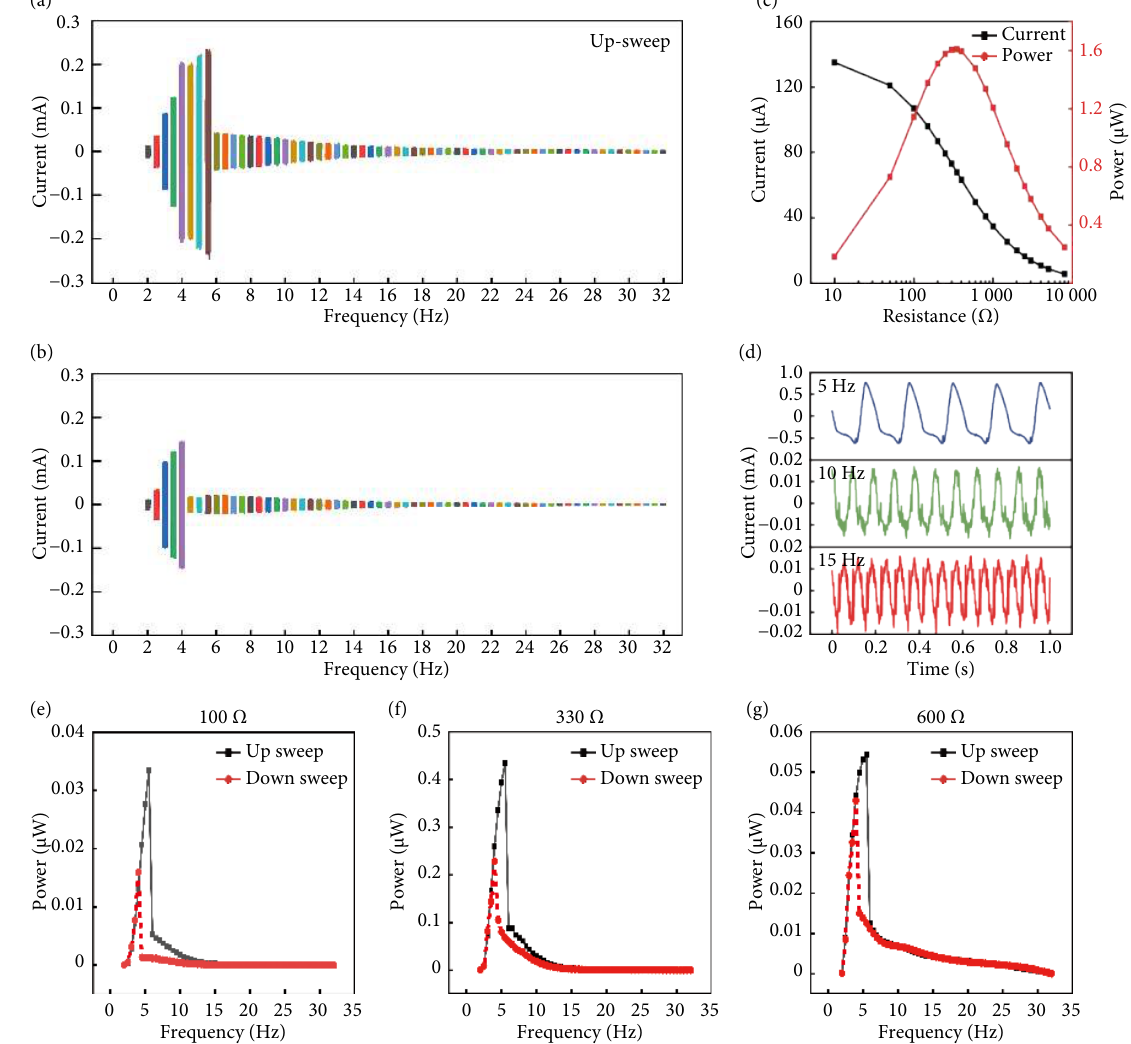
Fig. 3 Electric output of electromagnetic performance. (a, b) Short-circuit current under up-sweep and down-sweep and (c) current and power output under different resistance. (d) Typical current curve under 5 Hz, 10 Hz, and 15 Hz and (e–g) peak power under 100 Ω, 330 Ω, and 600